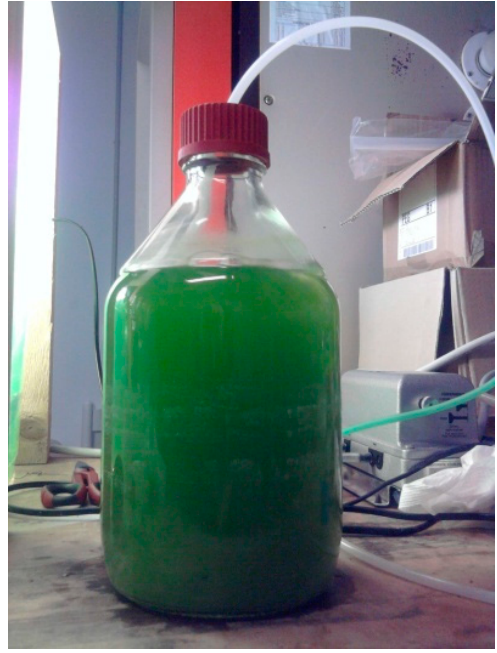
Figure 2. Glass batch reactor.